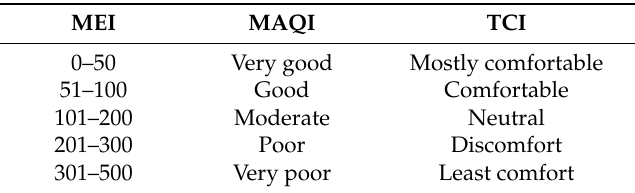
Table 3. Break points for the mine environmental index